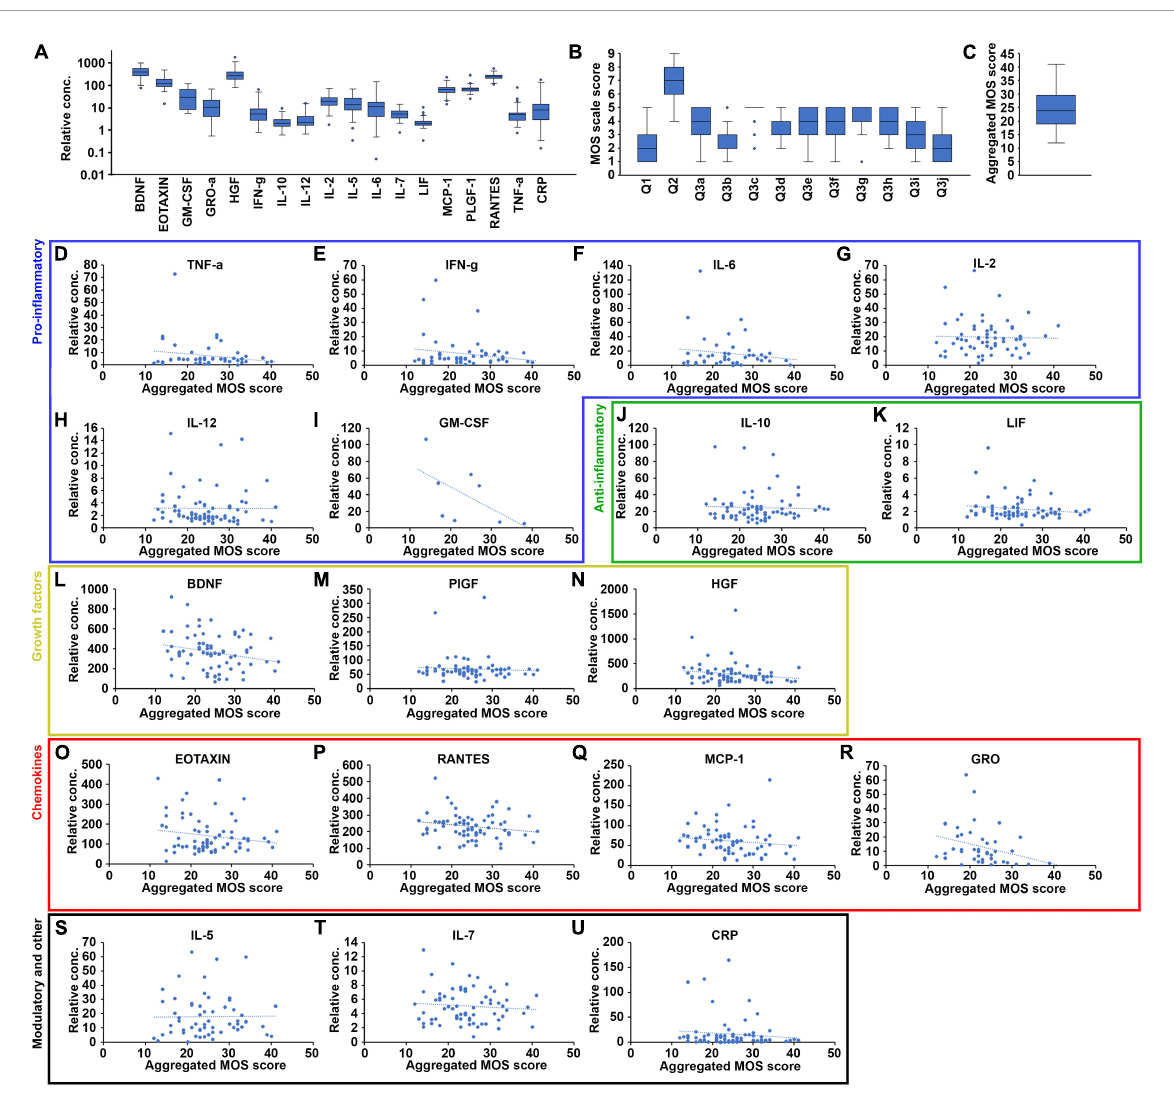
FIGURE3 Correlation between cytokine biomarker plasma levels and sleep quality at baseline for some but not all of the 17 selected cytokines. (A) Quantification of the plasma levels of the 17 biomarkers for the fully evaluated patients at baseline, shown as a box-plot with the median values represented as a black lines, and the 95% confidence intervals contained within the error bars ( n = 71). (B) Quantification of the range of scores given to each of the 12 questions included in the MOS sleep scale for the fully evaluated patients at baseline, shown as a box-plot with the median values represented as black lines and the 95% confidence intervals contained within the error bars ( n = 71). (C) The range of aggregated MOS scores calculated form the answers to the 12 individual questions of the MOS sleep scale for the fully evaluated patients at baseline, shown as a box-plot with the median value represented as a black line and the 95% confidence interval contained within the error bars ( n = 71). Plasma levels of each of the 17 selected biomarkers plotted against the aggregated MOS score of the same patient, for all fully evaluated patients at baseline. The biomarkers were organized into functional groups including pro-inflammatory ( D–I , blue box), anti-inflammatory ( J,K , green box), growth factors ( L–N , yellow box), chemokines ( O–R , red box), and immune-modulatory and other ( S–U , black box) biomarkers. N = 71, blue dashed lines indicate linear regression curves for the sample